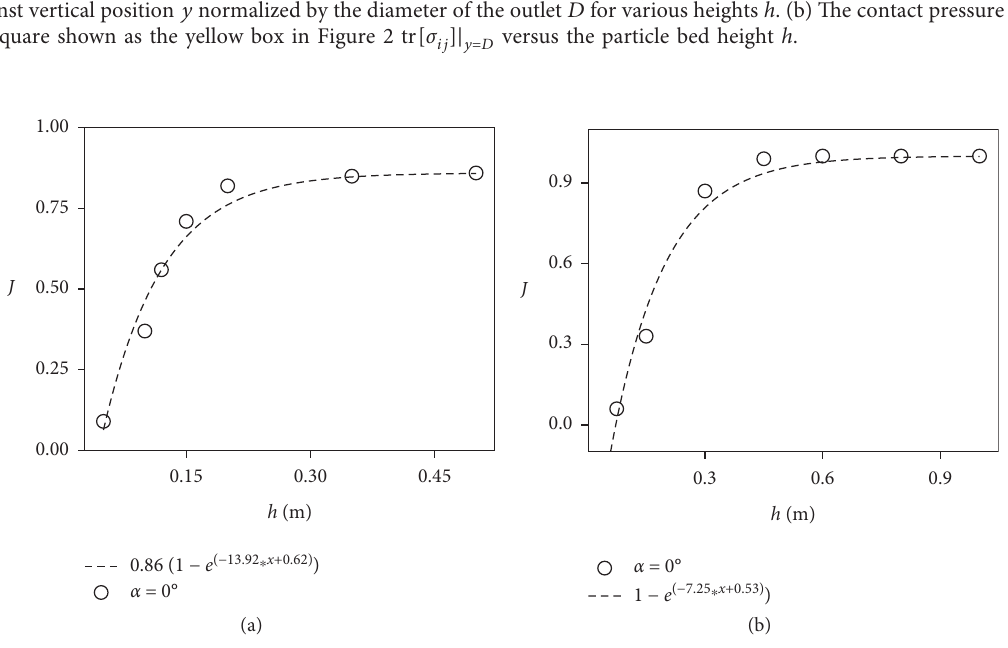
� 0.86, C � 13 . 92, and C � 0 . 62 in (a) (respectively, J inf 1 2